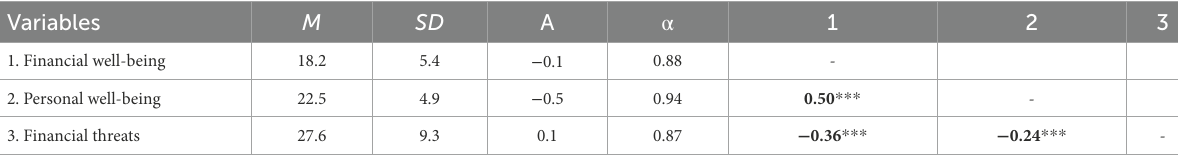
TABLE 2 Descriptive statistics, internal consistencies, and correlations for the study